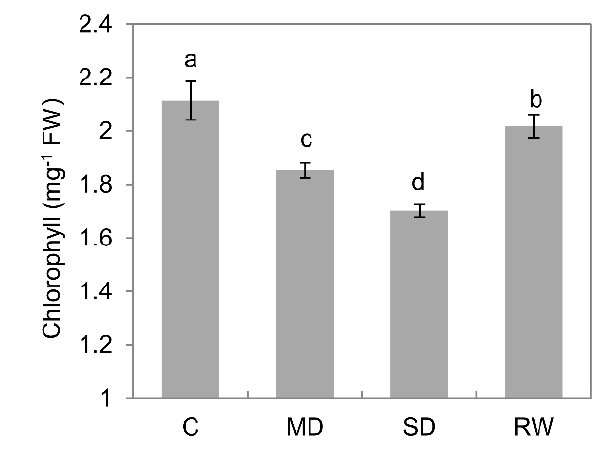
Figure 3. Effects of drought stress on the chlorophyll content of C. duriuscula . C-control, MD-mild stress, SD-severe stress, RW-re-watering. Data are means ± SE ( n = 3-6). Data labeled with different lower-case letters are significantly different at p < 0.05.